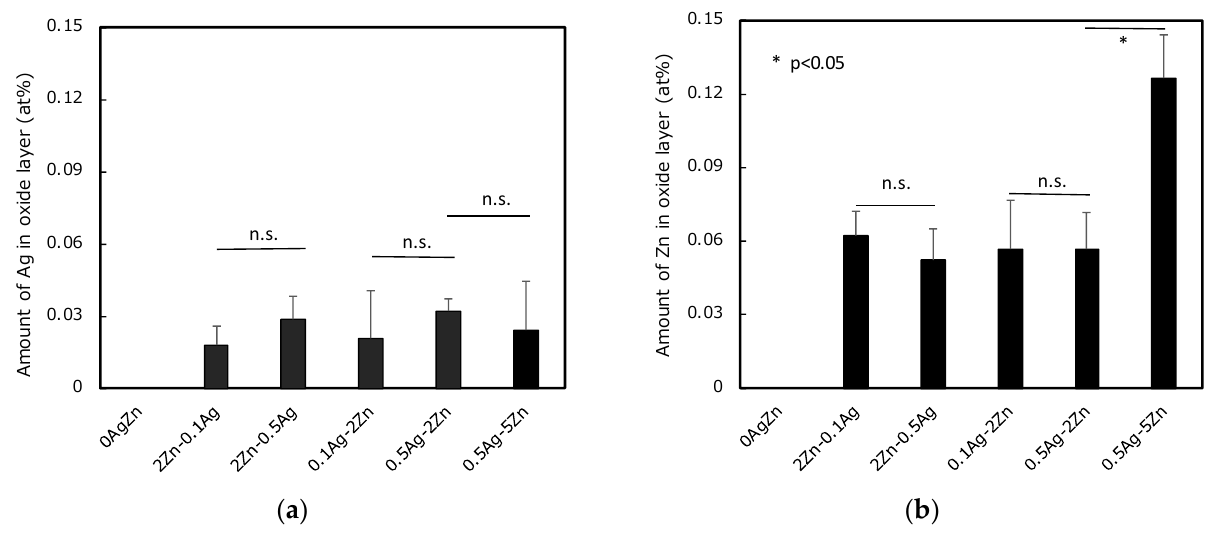
Figure 4. Amounts of ( a ) Ag and ( b ) Zn in the oxide layer measured via EDS (* statistically significant difference, p < 0.05; n.s.: no significant difference). Measurements were performed on three equally conditioned specimens ( n = 3).